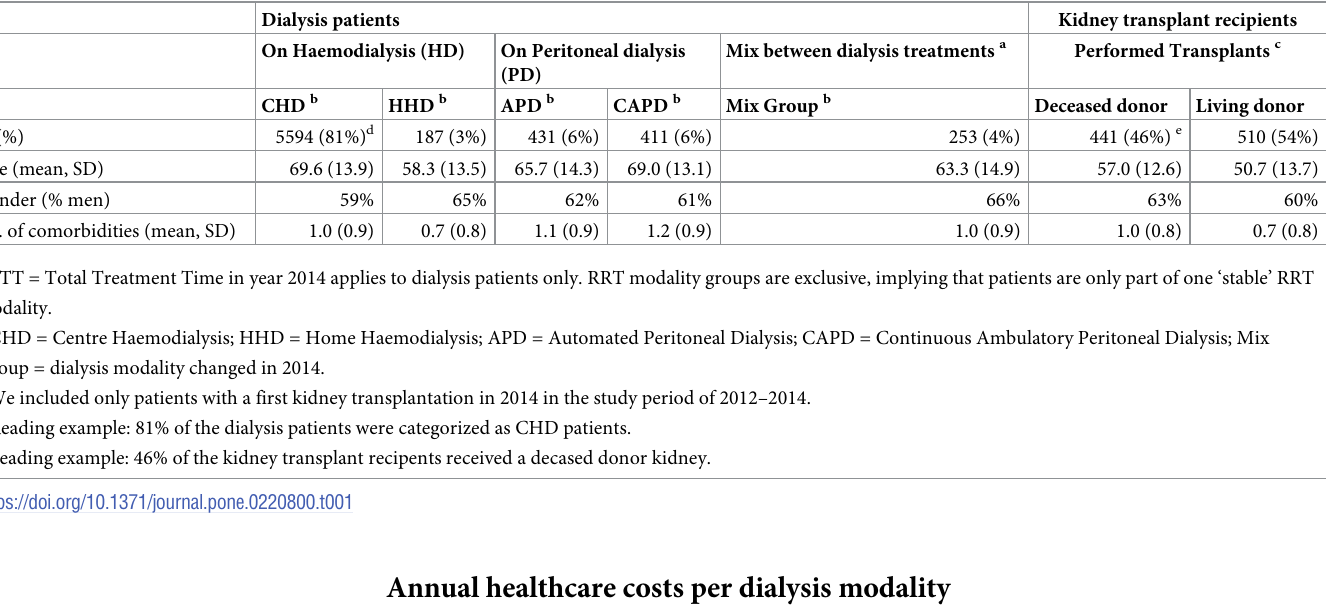
Table 1. Patient characteristics per RRT modality ( > 75% TTT a ) in the year 2014.